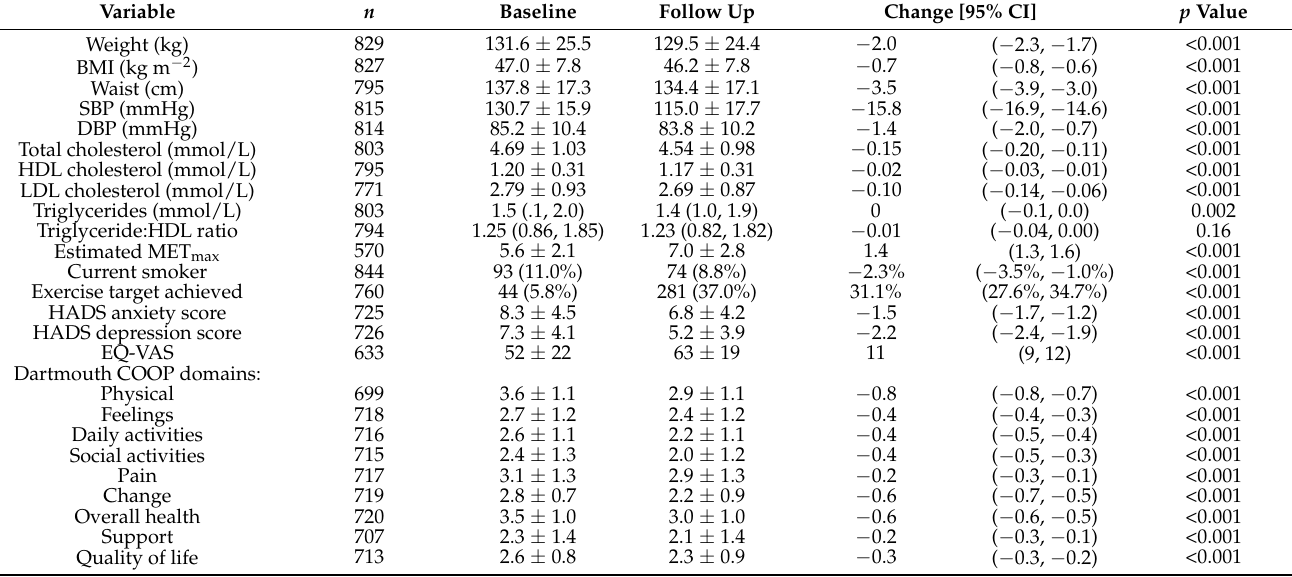
Table 2. Baseline and follow-up anthropometric, metabolic, quality-of-life, anxiety and depression measures from 877 CLANN programme